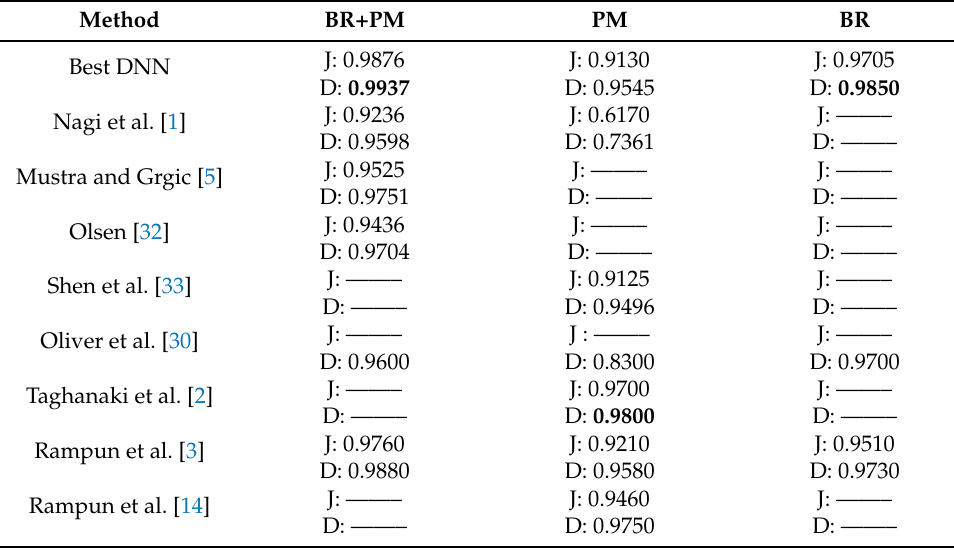
Table 9. Comparison of the best net with other proposals. Best results in